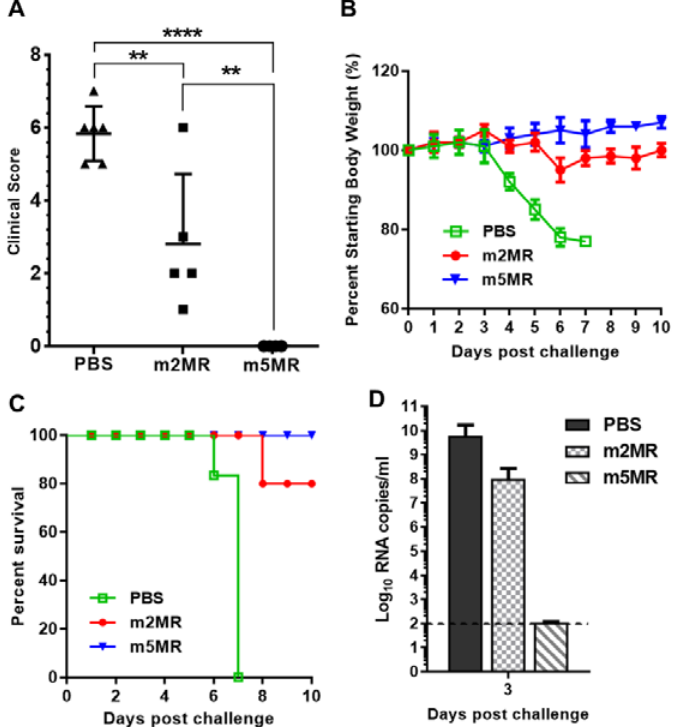
Figure 5. Mutant virus-infected animals are protected from lethal challenge. ( A ) Clinical scores, ( B ) weight loss, and ( C ) survival of the animals injected with PBS ( n = 6), or infected with m2MR ( n = 5), m5MR ( n = 6), and after 28 days, challenged s.c. with 10,000 PFU rMR virus. ( D ) rMR viremia in the plasma following challenge. The horizontal dashed line shows the limit of detection. Unpaired Student’s t -test (two-tailed) for panel A was used to determine significance. ****, p < 0.0001; **, p < 0.01.